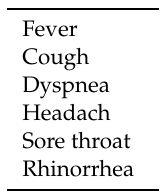
Table 1. Main COVID-19-associated